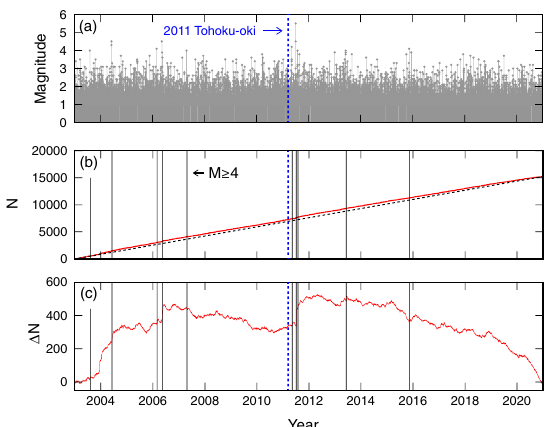
Fig. 5 a Magnitude–time plot for the M Wakayama swarm. The blue vertical line denotes the timing of the 2011 Tohoku–oki earthquake. b Cumulative number of M earthquakes (red line). The black dashed line denotes an average seismicity rate of 2.3 earthquakes per day (15,256 earthquakes over the 18-year analysis period). Vertical lines indicate when the M earthquakes occurred in the swarm. c Cumulative number (Δ N ) of M 1 earthquakes deviated from the average seismicity rate. It is ≥ noted that Δ N becomes zero at both ends of the analyzed period